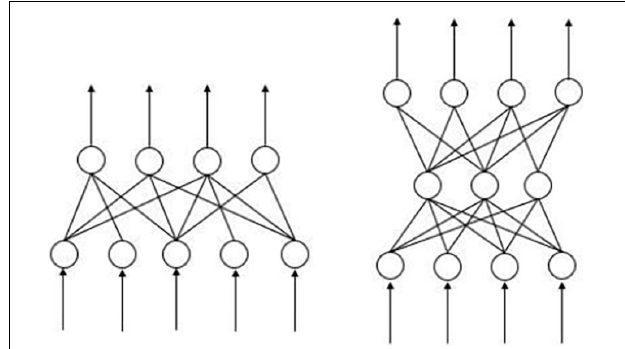
FIGURE 1 | Common two-layer and three-layer ANN